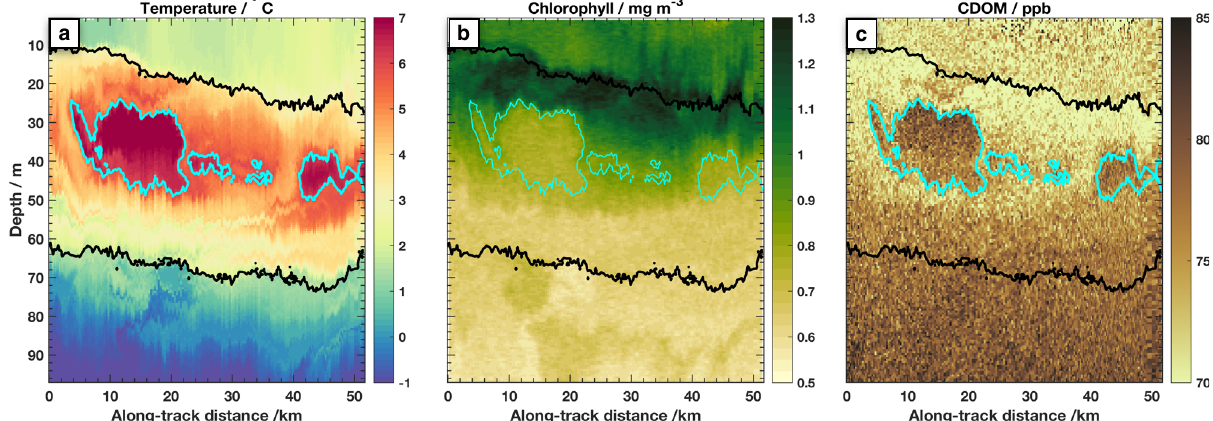
Fig. 6 Biogeochemical signatures of Paci fi c Summer Water (PSW): the section view. Observations along the Wirewalker drift of a Temperature, b Chlorophyll concentration, and c Chromophoric Dissolved Organic Matter (CDOM). CDOM is presented in parts-per-billion (ppb) based on factory calibration of the sensor. In each panel the 23.2 and 25.2 kg m − 3 isopcynals are contoured in black, and the 6 °C isotherm is contoured in